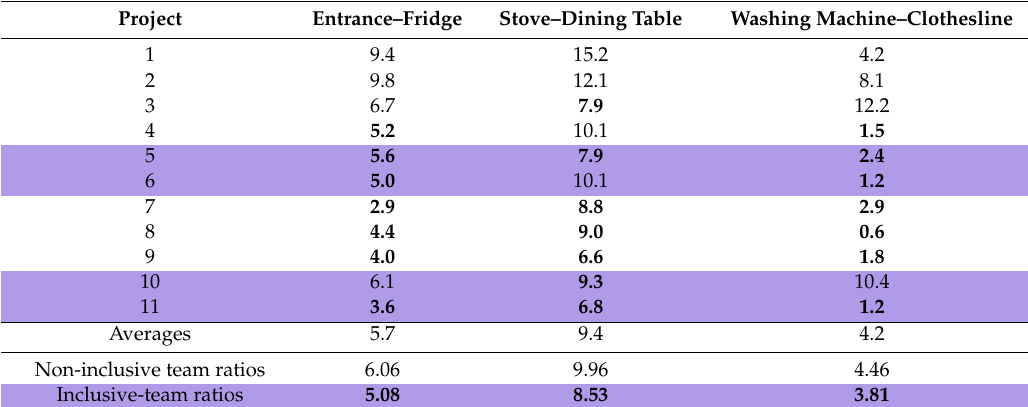
Table 2. Main reproduction task paths. Distance in